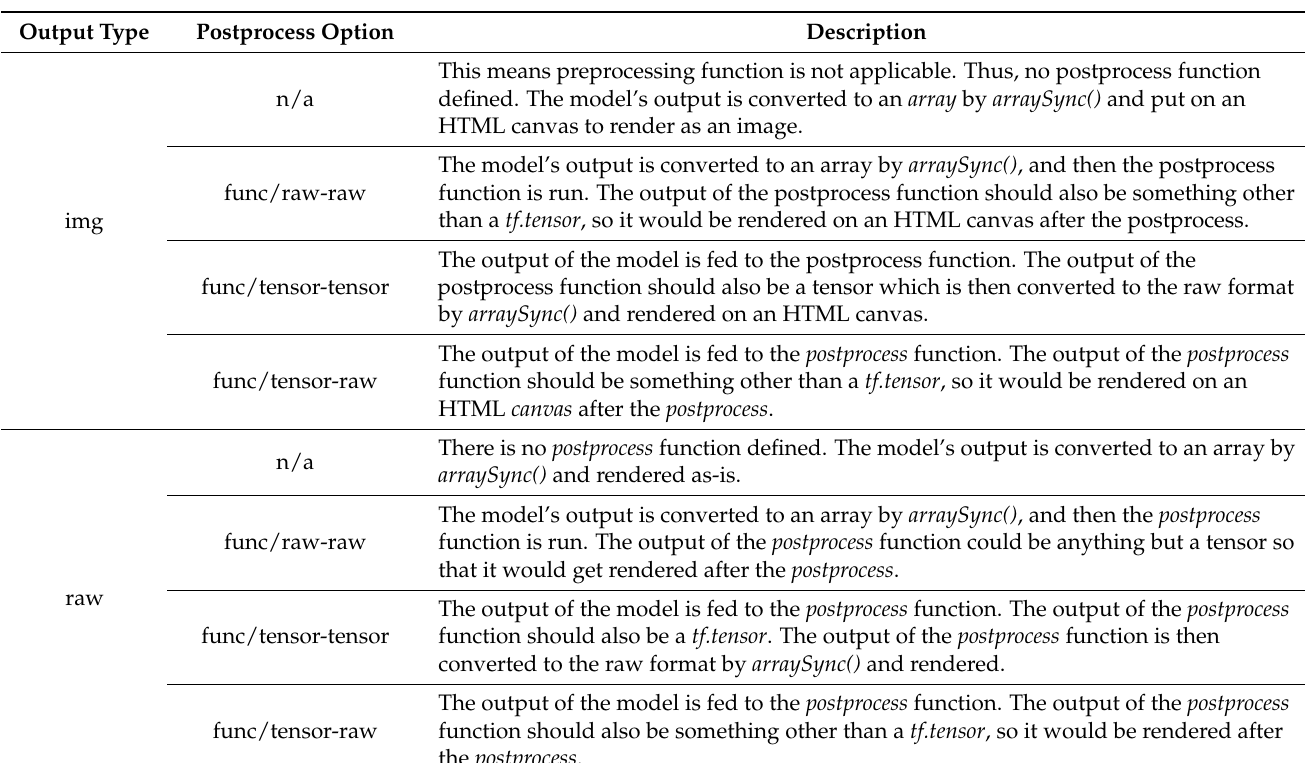
Table A5. Output types and available postprocessing types for each of the output types.